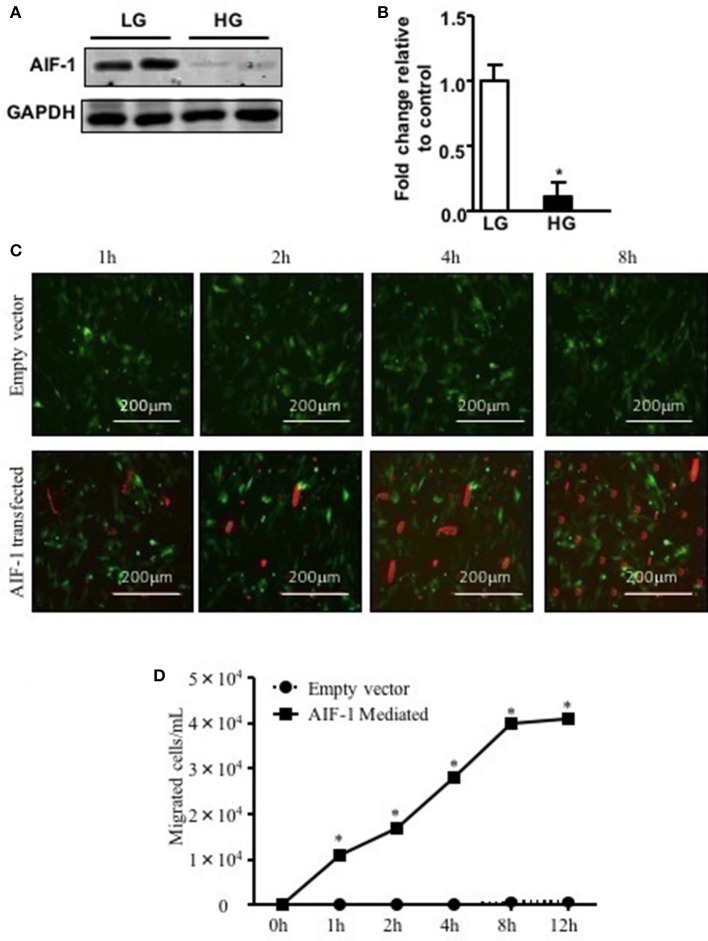
AIF-1 overexpression promoted B cell migration in hyperglycaemic condition. (A) Effect of hyperglycemia on AIF-1 expression using H9C2 cell line using immunoblot. (B) Analysis. (C) The H9C2 cells were transfected either with GFP-tagged AIF-1 plasmid or a GFP-empty vector and incubated for maximum 4 h. H9C2 cells were transfected either with a GFP tagged empty vector or GFP tagged AIF-1 plasmid. A20 cells transfected with RFP tagged empty vector and plated in the upper chamber. (D) Quantification of B cells migrated to AIF-1-transfected H9C2 cells. Green color represents the H9C2 cells as they were either transfected with GFP empty vector or GFP tagged AIF-1 plasmid; red color represents the A20 cell line as the A20 cells were transfected with RFP empty vector. (*p < 0.05 as biological significant level, Empty vector vs. AIF-1 plasmid), n = 4.